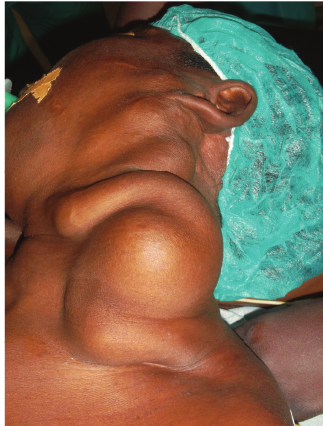
Figure 4: Scan reconstruction showing the contrast filing the cervical AVM.